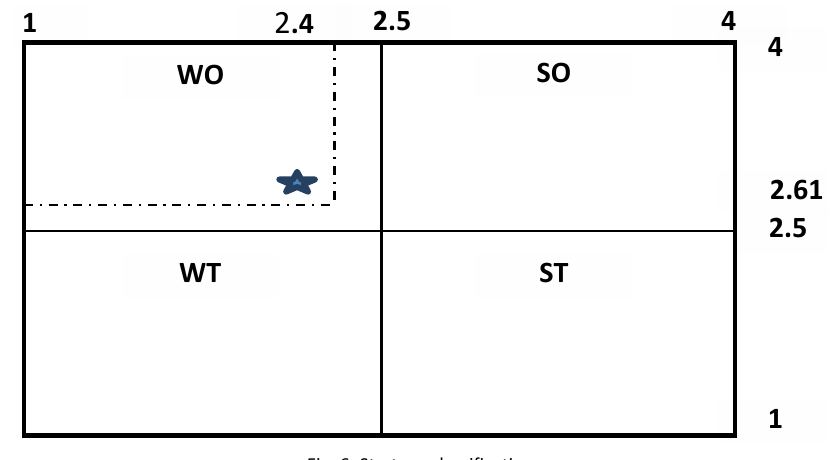
Table 4: Strategies prioritization by QSPM matrix in terms of total attractiveness coefficients of WO strategies